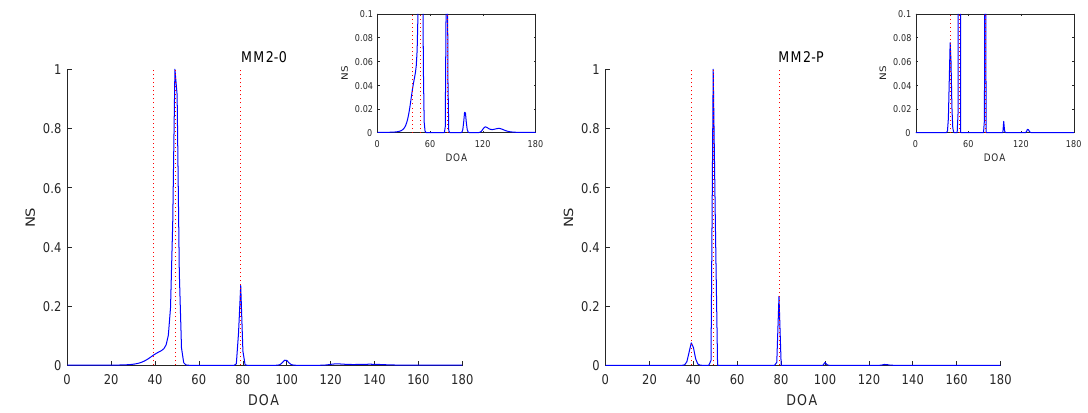
Figure 10. NSs of Experiment 3 with SNR = 0